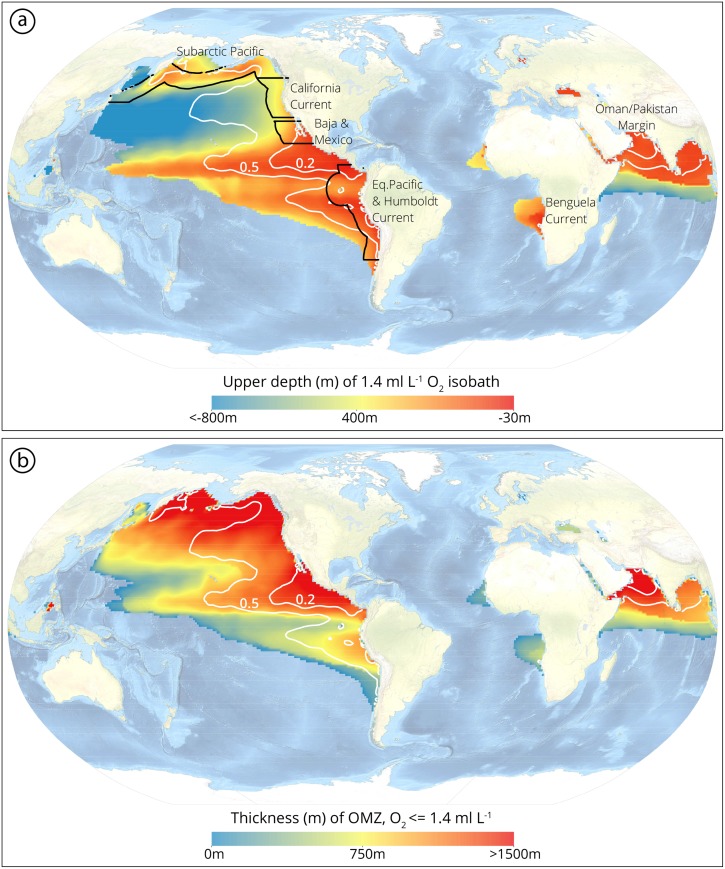
Global Oxygen Minimum Zones, including (a) Upper depth (in meters) of intermediate water hypoxia ([O2]<1.4 ml L-1) and (b) thickness (in meters) of intermediate water hypoxia ([O2]<1.4 ml L-1).The geospatial distributions of severely hypoxic [O2] minimums (of [O2] = 0.5 ml L-1 and [O2] = 0.2 ml L-1) are depicted on both panels as white lines. For the upper panel, regional blocks are defined by black lines to highlight where paleoxygenation reconstructions were completed. Data from World Ocean Atlas [192].